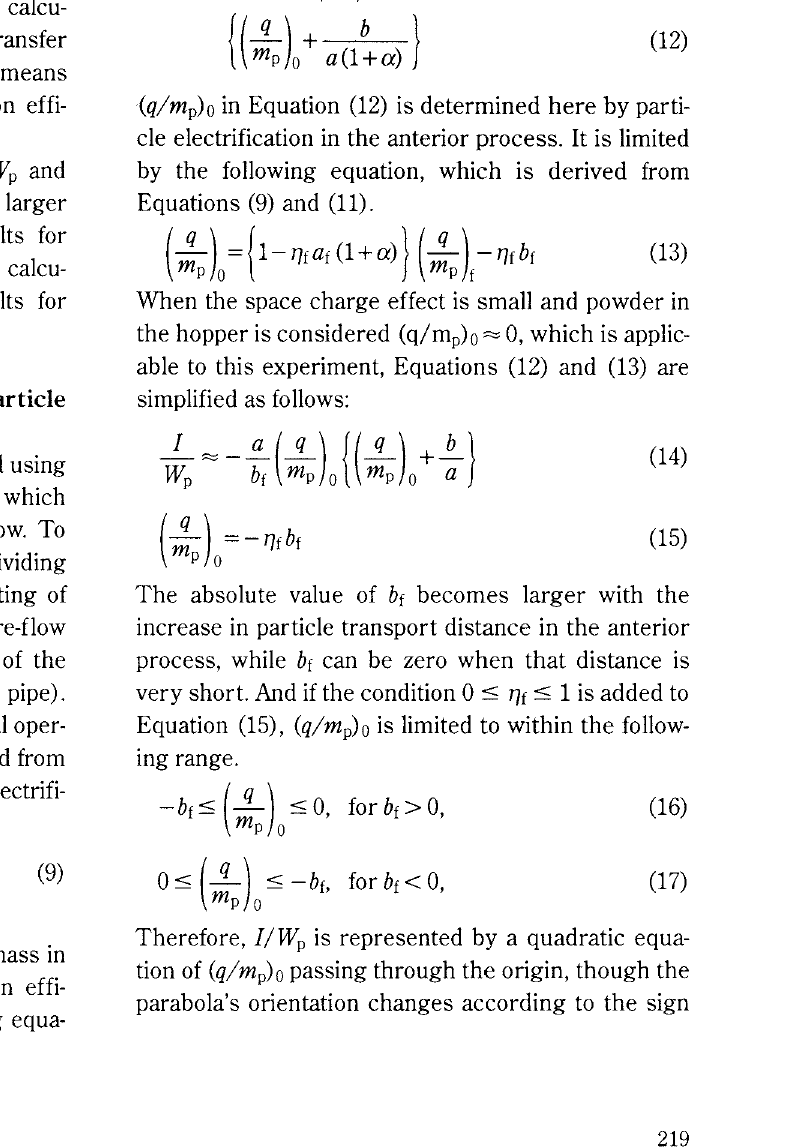
Fig. 6 Characteristic Line of Particle Electrification (Fly ash No. 5: Dpso = 12